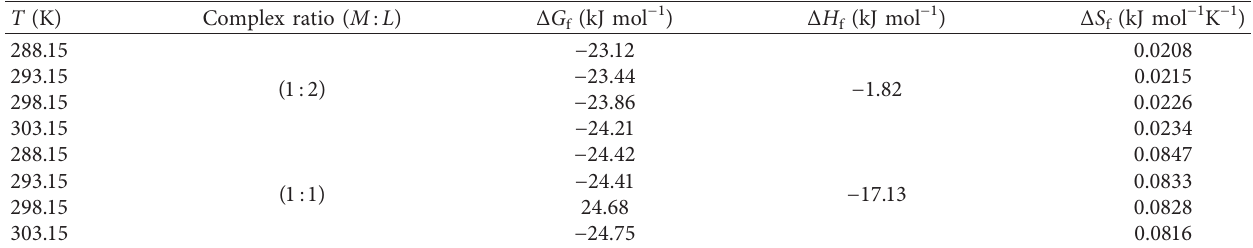
Table 10: Different formation parameters (Gibbs free energy of formation ( Δ G nano-Cu-CFT complex in distillate H 2 O at different temperatures.